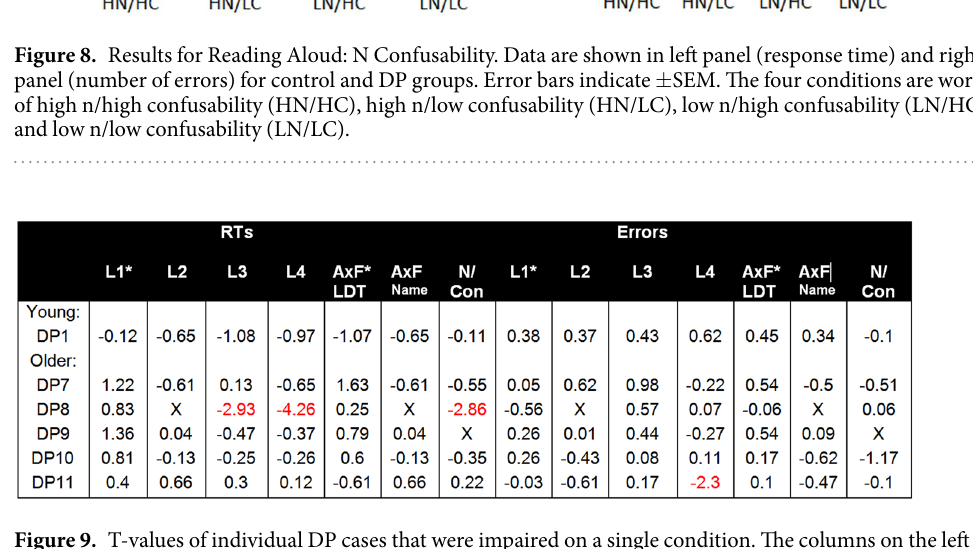
Figure 9. T-values of individual DP cases that were impaired on a single condition. The columns on the left show response time performance with the columns on the right showing the error rates. L1-L4 relates to the four length tasks in order as presented in our Results section. AxF LDT = Age of Acquisition × Frequency Lexical Decision task, AxF Name = Age of Acquisition × Frequency Naming task, N/Con = N × Confusability task. Asterisks highlight lexical decision tasks and Xs denote tasks that were not completed by the